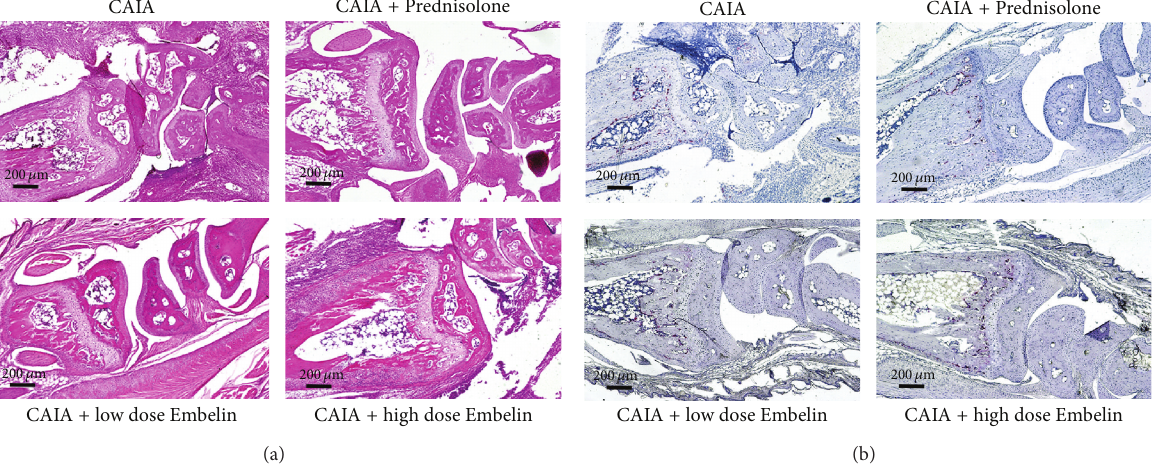
Figure 2: (a) Representative hematoxylin-eosin staining within the radiocarpal joint from each mouse group. (b) Representative TRAP staining (red) in the radiocarpal joint from each mouse group. Hematoxylin counterstaining.